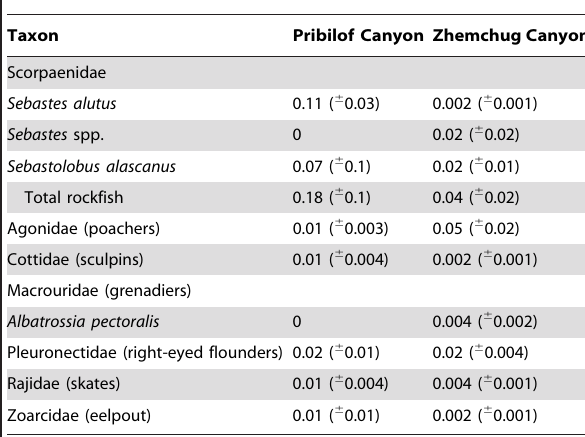
Table 2. Mean density estimates (numbers m 2 2 6 S.E.) of common fishes in Pribilof and Zhemchug Canyons, Bering Sea.